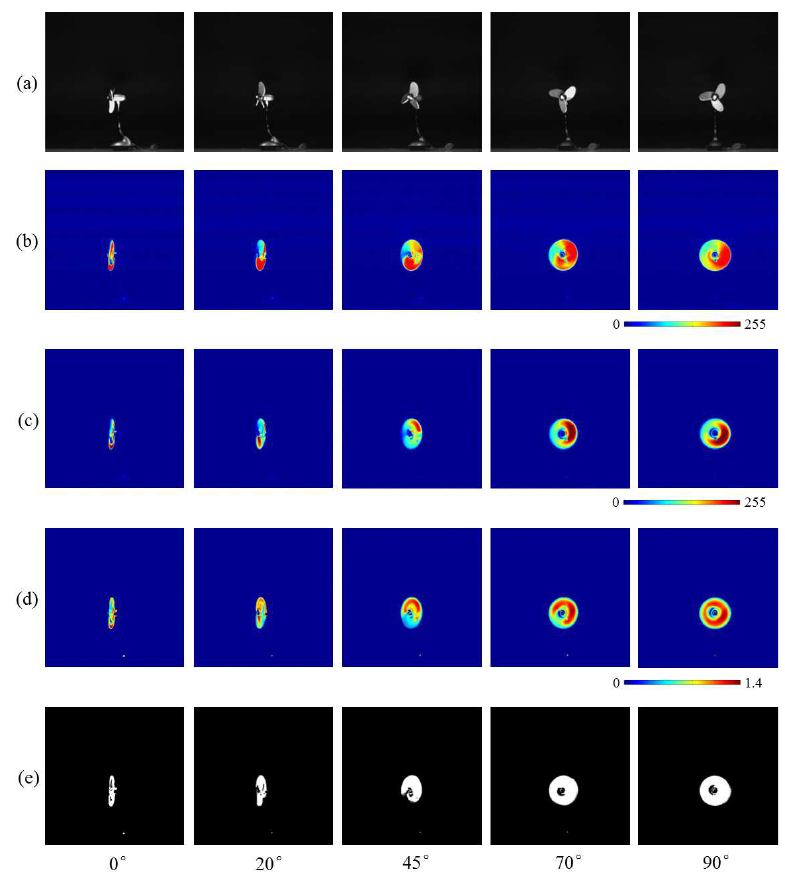
Figure 10. ( a ) Input images; amplitude of ( b ) input; and ( c ) pixel-wise filtered images; ( d ) amplitude ratios; ( e ) extracted vibration features.